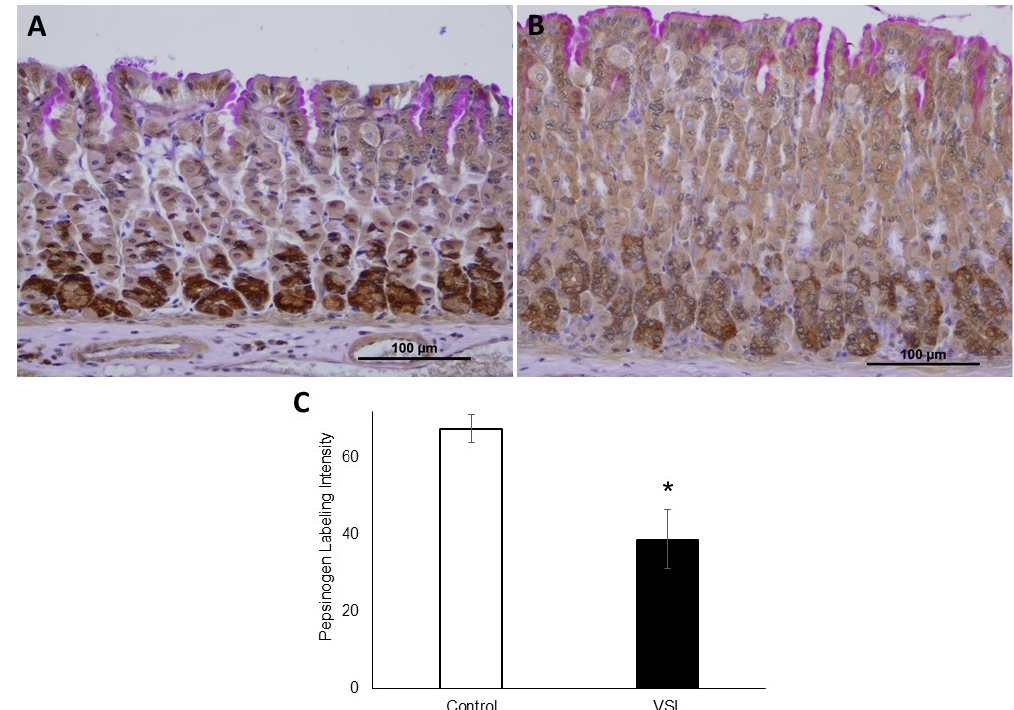
Figure 7. Immunohistochemical analysis of pepsinogen immunolabeling in tissue sections obtained from the gastric mucosae of control ( A ) and VSL-treated ( B ) mice. Magnification bar = 100 µm. Analysis of pepsinogen-labeling intensity per field in the oxyntic glands of control and VSL treated mice ( C ). Data from three control and three VSL-mice are presented as mean ± SE. The asterisk indicates significant differences from the control group. * p < 0.05.